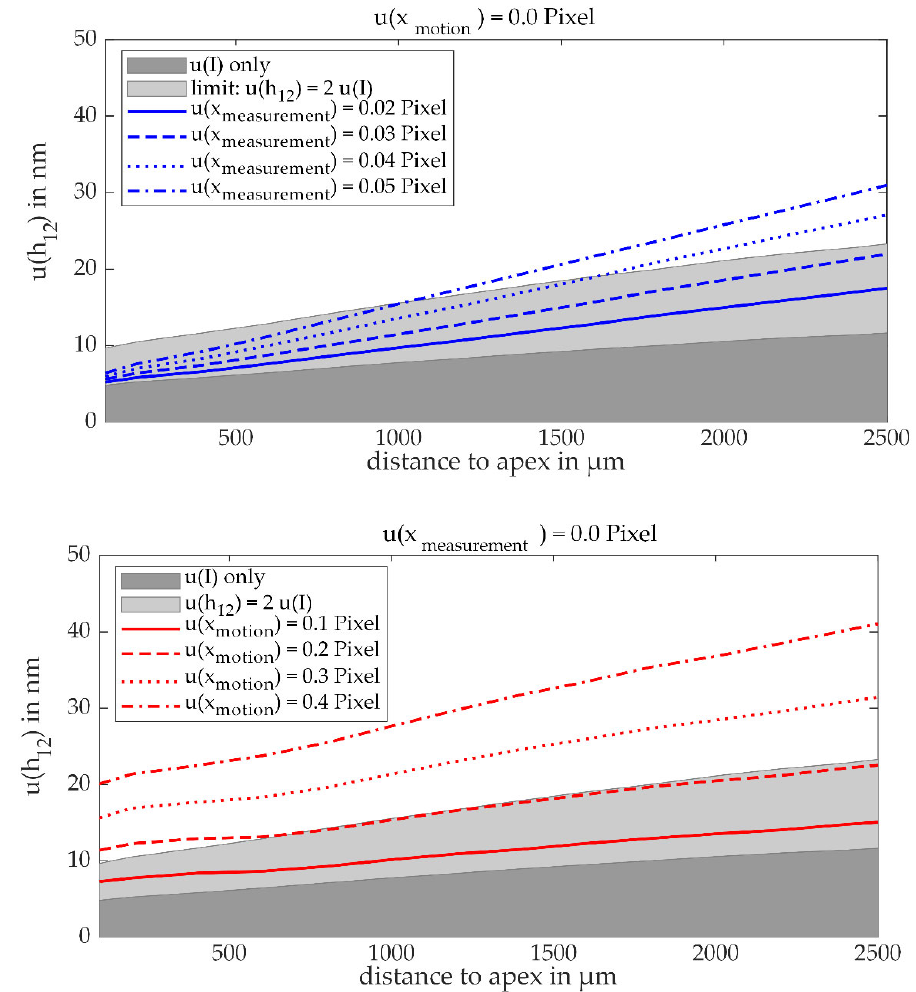
Figure 5. Resulting height uncertainty due to various levels of displacement measurement uncertainty and motion uncertainty. The dark grey area marks the uncertainty resulting from the intensity noise only. The light grey area marks the set limit of total height uncertainty equal to twice the intensity noise contribution. Top: The blue lines represent total height uncertainties, which are caused by varying amounts of displacement measurement uncertainty. Bottom: The red lines depict height uncertainties, which are caused by varying amounts of motion uncertainty.